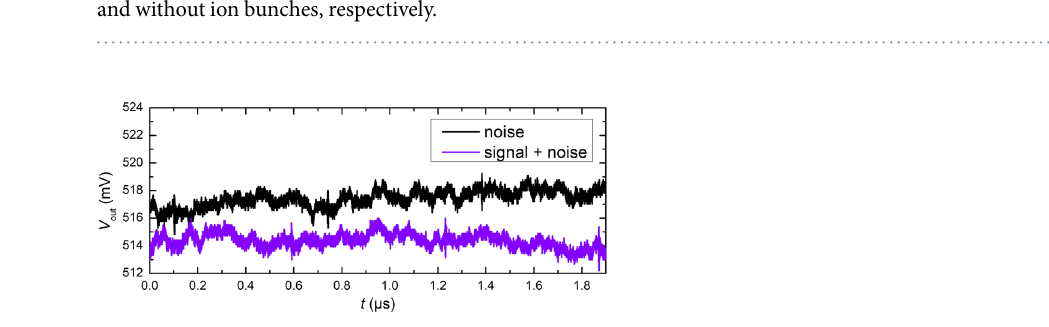
Table 1. Detection and false positive rates for different thresholds set in the live FFT of single acquisitions with and without ion bunches,